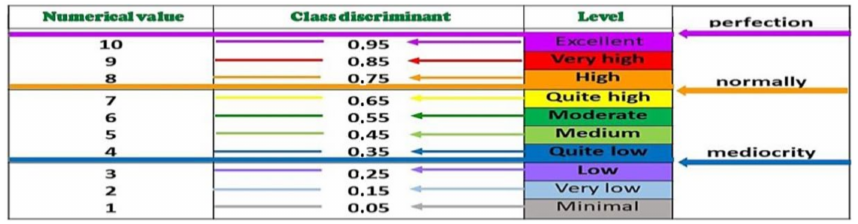
Figure 3. The universal scale of relative states.